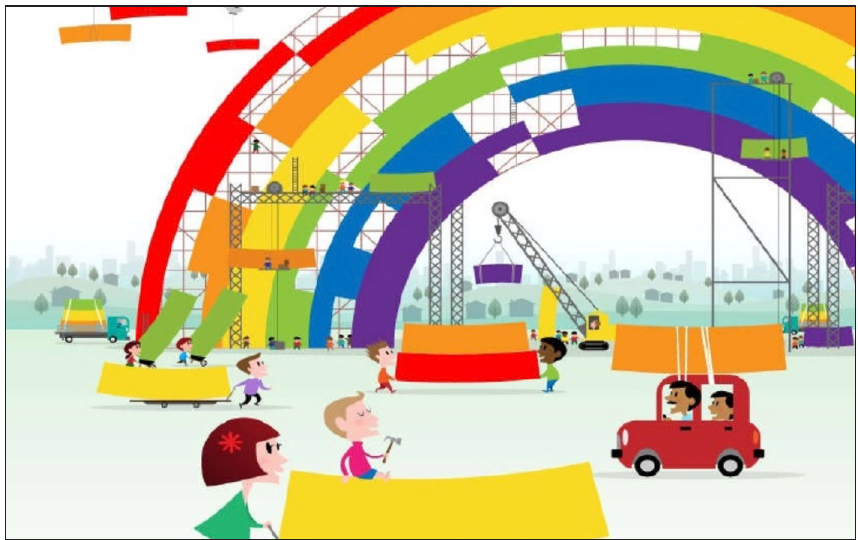
Figure 1: The branding used at the Dept for Children Schools and Families, empha- sising inclusion and investment. This was quickly sidelined after its closure in 2010: the early intervention budget was cut by 55%, family support services cut by 24%, and spending on children’s centres cut by 17% between 2010–2014 (The Children’s Society,